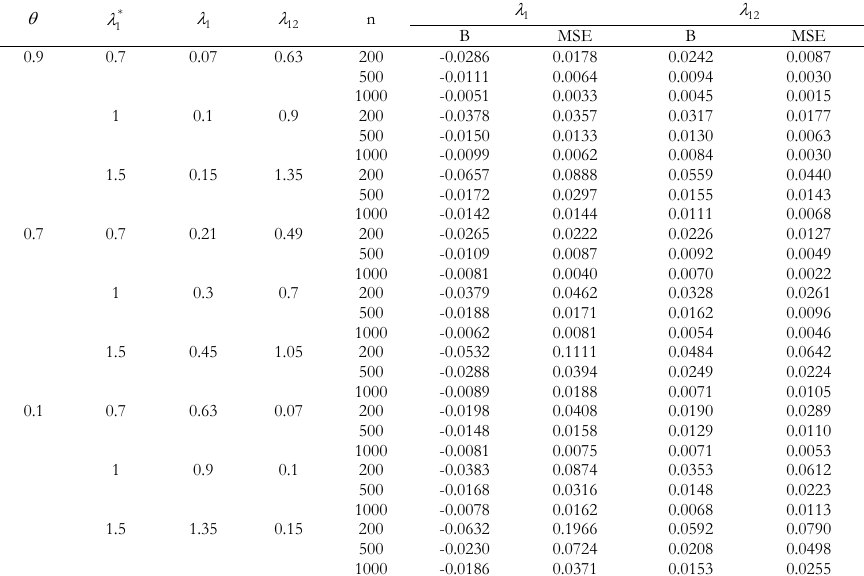
Estimates of the exponential reliability parameters: complete